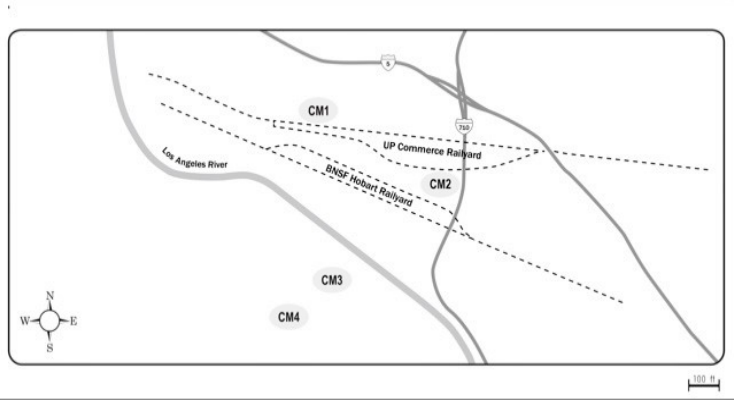
Figure 2. Map of the Commerce railyards with locations of air collection sites.